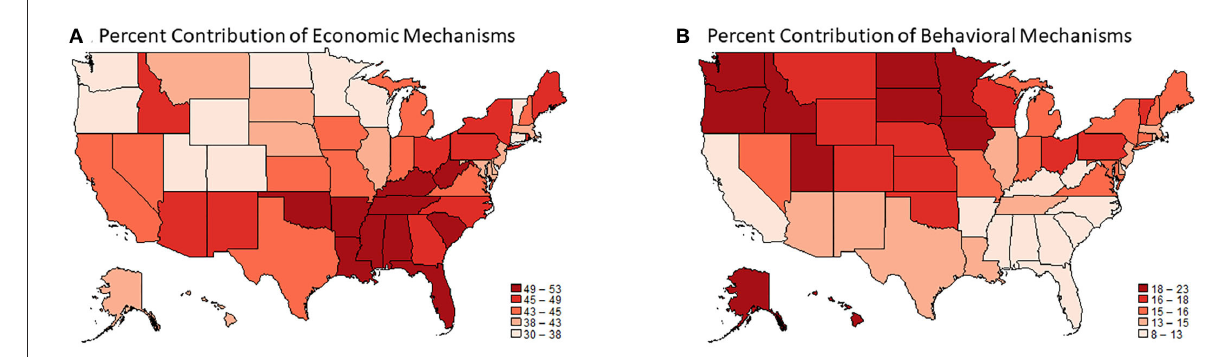
FIGURE4 The contribution of economic (A) and behavioral (B) mechanisms to the education-health association in U.S. states. Data are from the 2011–2018 Behavioral Risk Factor Surveillance System and include adults ages 25–64. The magnitude of the education-health association is the difference in the probably of favorable health among adults with at least a 4-year college degree minus the probability of favorable health among adults without a 4-year college degree. The probabilities are estimated from state-specific logistic regression models which include an indicator for college degree, age, sex, race-ethnicity, and calendar